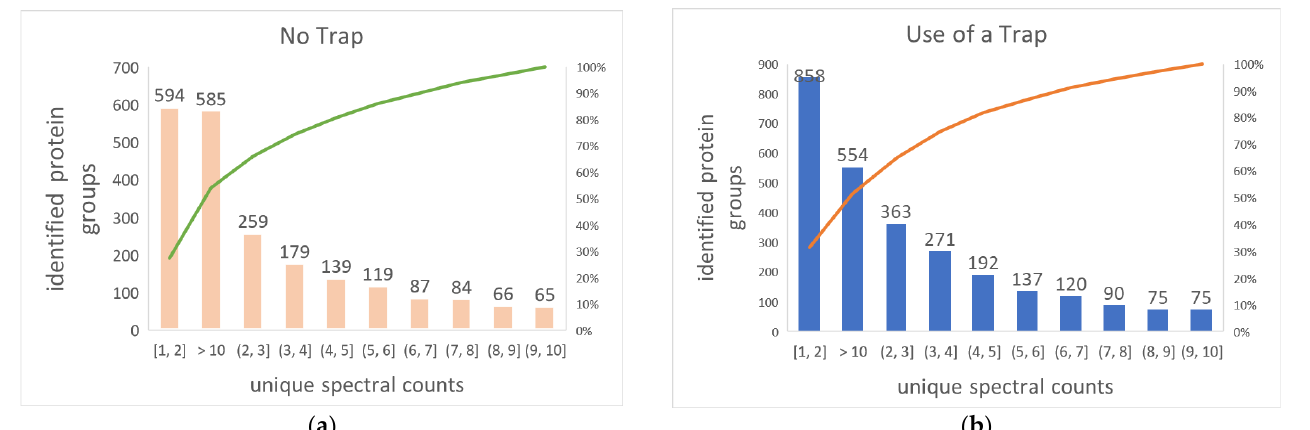
Figure 12. Low-abundance proteins and unique spectral counts. Histograms illustrate the distribution of identified proteins as reflected by respective covered unique spectral counts ( a ) no trap column; ( b ) inclusion of a trap column on the column. The mean and standard deviation of triplicate injections are shown for the number of identified protein groups covering varying number of unique spectral counts.